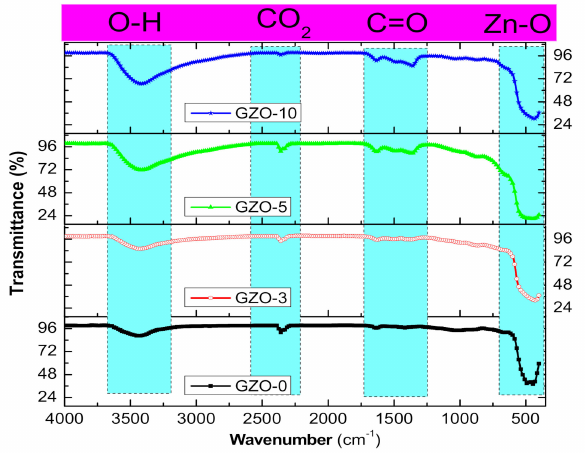
Figure 3. The absorption FTIR spectra as-synthesized Ga doped ZnO (GZO-0, GZO-3, GZO-5, and GZO-10)